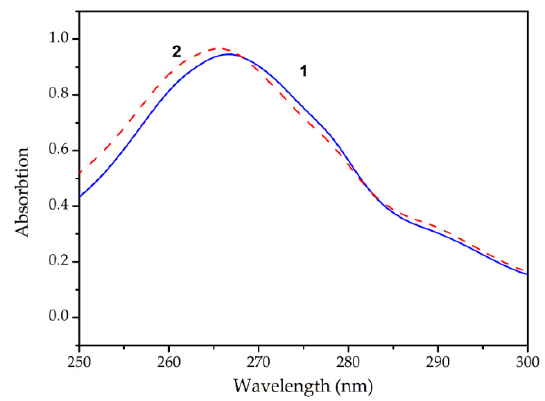
Figure 1. Absorption spectra of complexes 1 . Tb(Phen) and 2 . Tb(Phen)-AA.